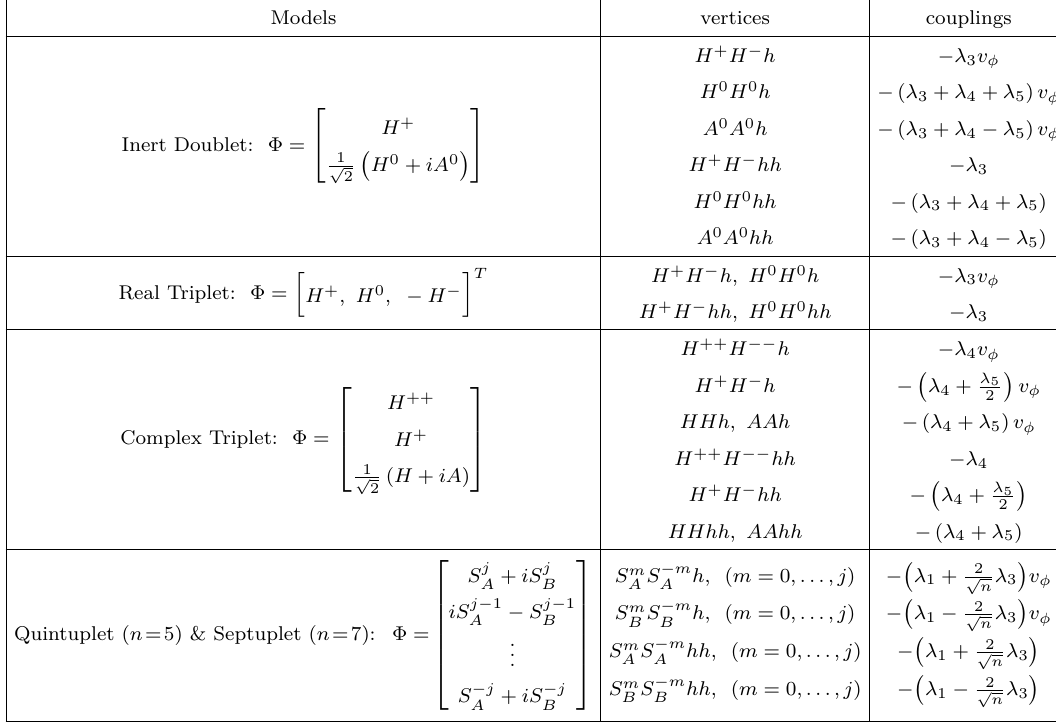
Table 4. Feynman rules in the scalar potential for Inert Doublet, Real/Complex Triplet, Quintuplet and Septuplet